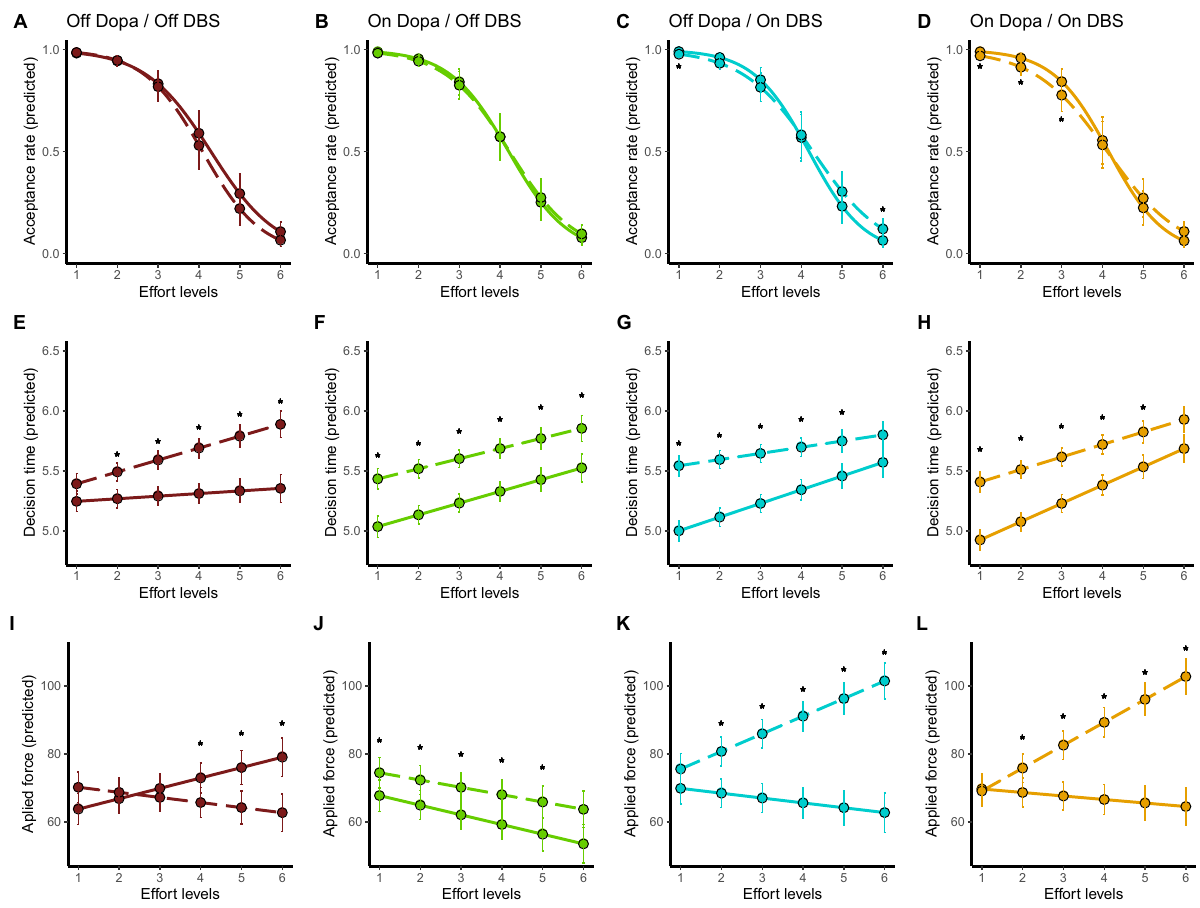
Figure 2. Acceptance rate (part A to part D ), decision time (parts E to part H ) and applied force (part I to L ) per treatment, efforts nature and efforts levels. Solid lines represent hand efforts and dashed lines represent phonation efforts. The applied force corresponds to the percentage of maximal effort performed during the calibration